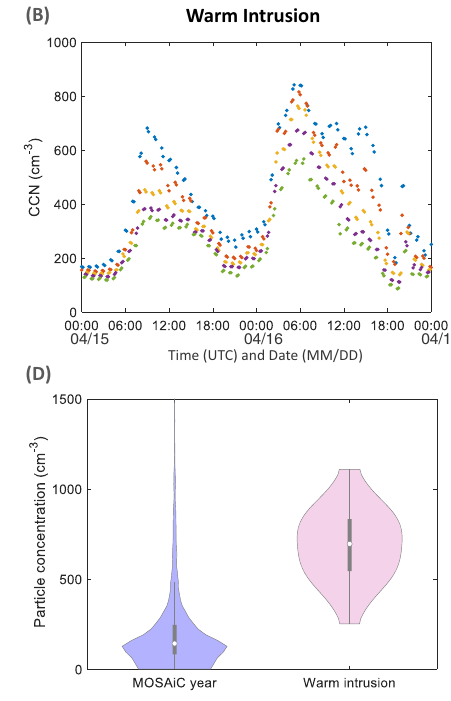
Fig. 6 | Effect of warm intrusion on cloud condensation nuclei. Time series of CCN number concentrations at different supersaturation (SS) during ( A ) back- ground period and ( B ) warm intrusion period (10min averages). C Violin dis- tribution plots of hourly averaged CCN number concentration for the whole MOSAiCyeardata(inlila)andwarmintrusiondata(inpink — excludingprecipitation periods). D Violin distribution plots of hourly averaged particle number con- centrationfromaCPCwithalowercutoffof>2.5nmforthewholeMOSAiCyear(in lila)andwarmintrusiondata(inpink — excludingprecipitationperiods).Violinplots